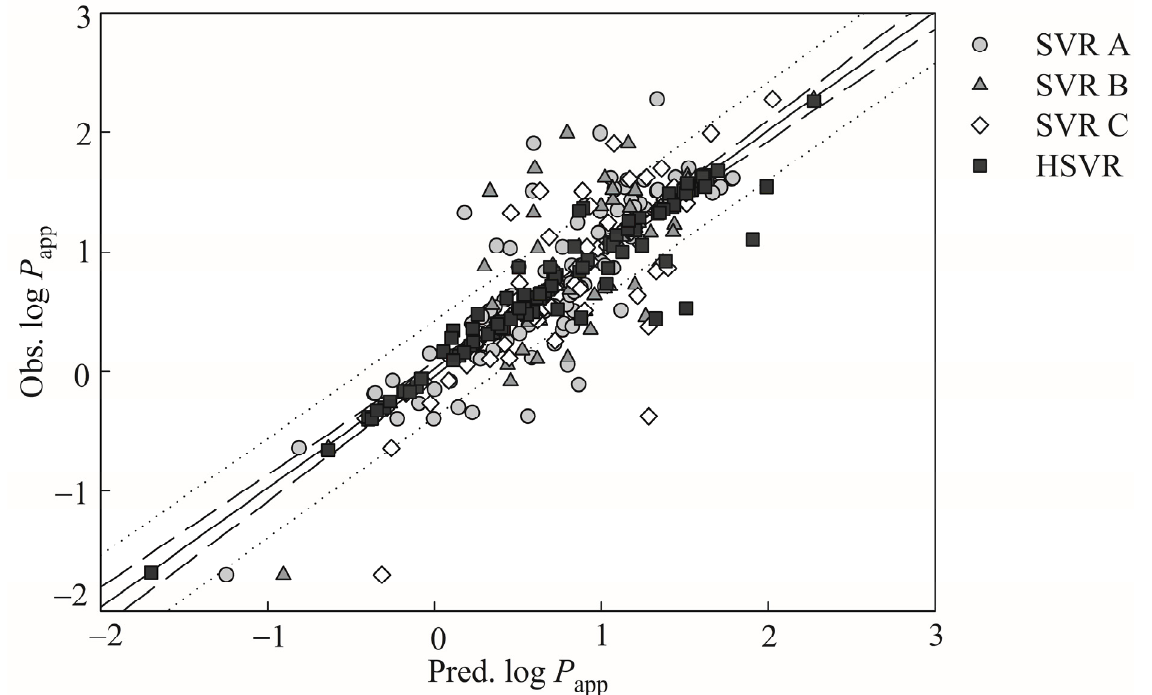
Figure 2. Observed log P app versus the log P app predicted by SVR A (gray circle), SVR B (gray triangle), SVR C (open diamond), and HSVR (solid square) for the training samples. The solid, dashed, and dotted lines represent to the HSVR regression of the data, 95% confidence intervals for the HSVR regression, and 95% confidence intervals for the HSVR prediction, respectively.